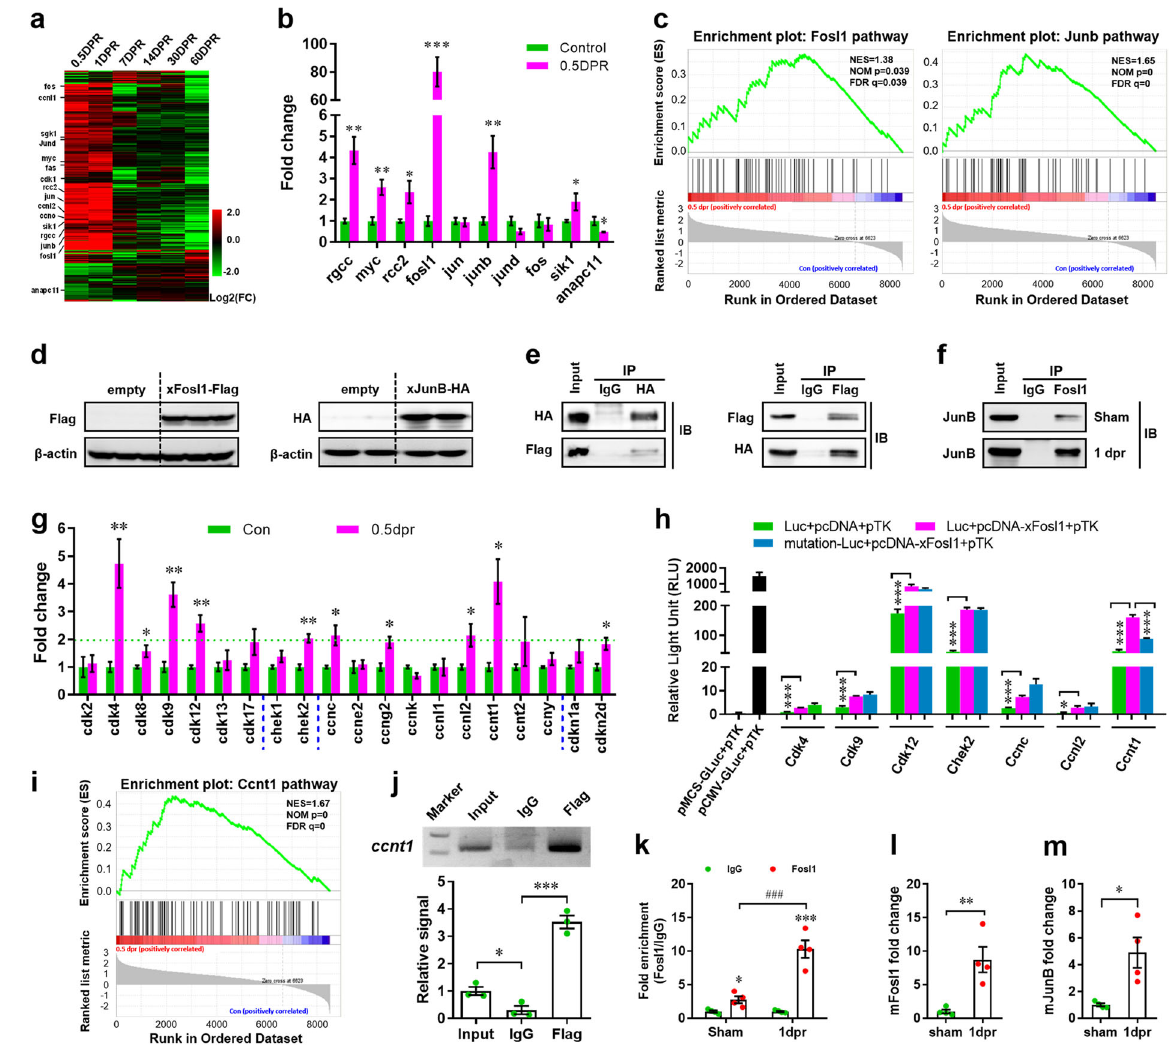
Fig. 5 Fosl1 interacts with JunB and promotes ccnt1 expression during heart regeneration in X. tropicalis . a Heat map of log2(FC) values showing genes differentially expressed in the hearts at 0.5, 1, 7, 14, 30, and 60 dpr compared with sham. b The qPCR of some selected regulators for cell cycle progression in sham and 0.5 dpr hearts ( n = 4 each). c GSEA analysis of hearts at 0.5 dpr showing high correlations with Fosl1 (left) and JunB (right) pathways. d Expression of Flag-tagged xFosl1 (left) and HA-tagged xJunB (right) in X. tropicalis embryos was con fi rmed by western blotting. e CoIP assay showing the interaction between xFosl1-Flag and xJunB-HA in X. tropicalis embryos. f CoIP analysis showing the increased interaction between Fosl1 and JunB in regenerating neonatal mouse heart compared with the quiescent heart. g qPCR validation of cell cycle regulators with signi fi cant upregulation in RNA-seq analysis ( n = 4 each). h Promoters of the cell cycle regulators with more than twofold upregulation were subjected to luciferase activity assay, using reporter plasmids and mutants ( n = 5 each). i GSEA analysis of the hearts at 0.5 dpr showing high correlations with Ccnt1 pathway. j Representative image of ChIP assay con fi rmed the in vivo interaction of Fosl1 with promoters of ccnt1 in X. tropicalis embryos. k ChIP-qPCR analysis showing the increased interaction between Fosl1 protein and Ccnt1 promoter region in regenerating neonatal mouse heart compared with quiescent heart. l , m qPCR validation of Fosl1 ( l ) and JunB ( m ) in sham and resected hearts of neonatal mice ( n = 4 each). All data are presented as mean ± SEM, * p < 0.05, ** p < 0.01, *** p < 0.001 versus control (Student ’ s t